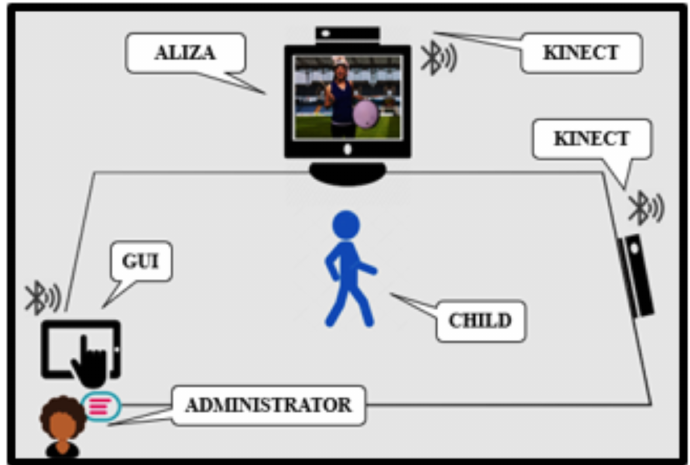
Figure 2. hlData collection setup.